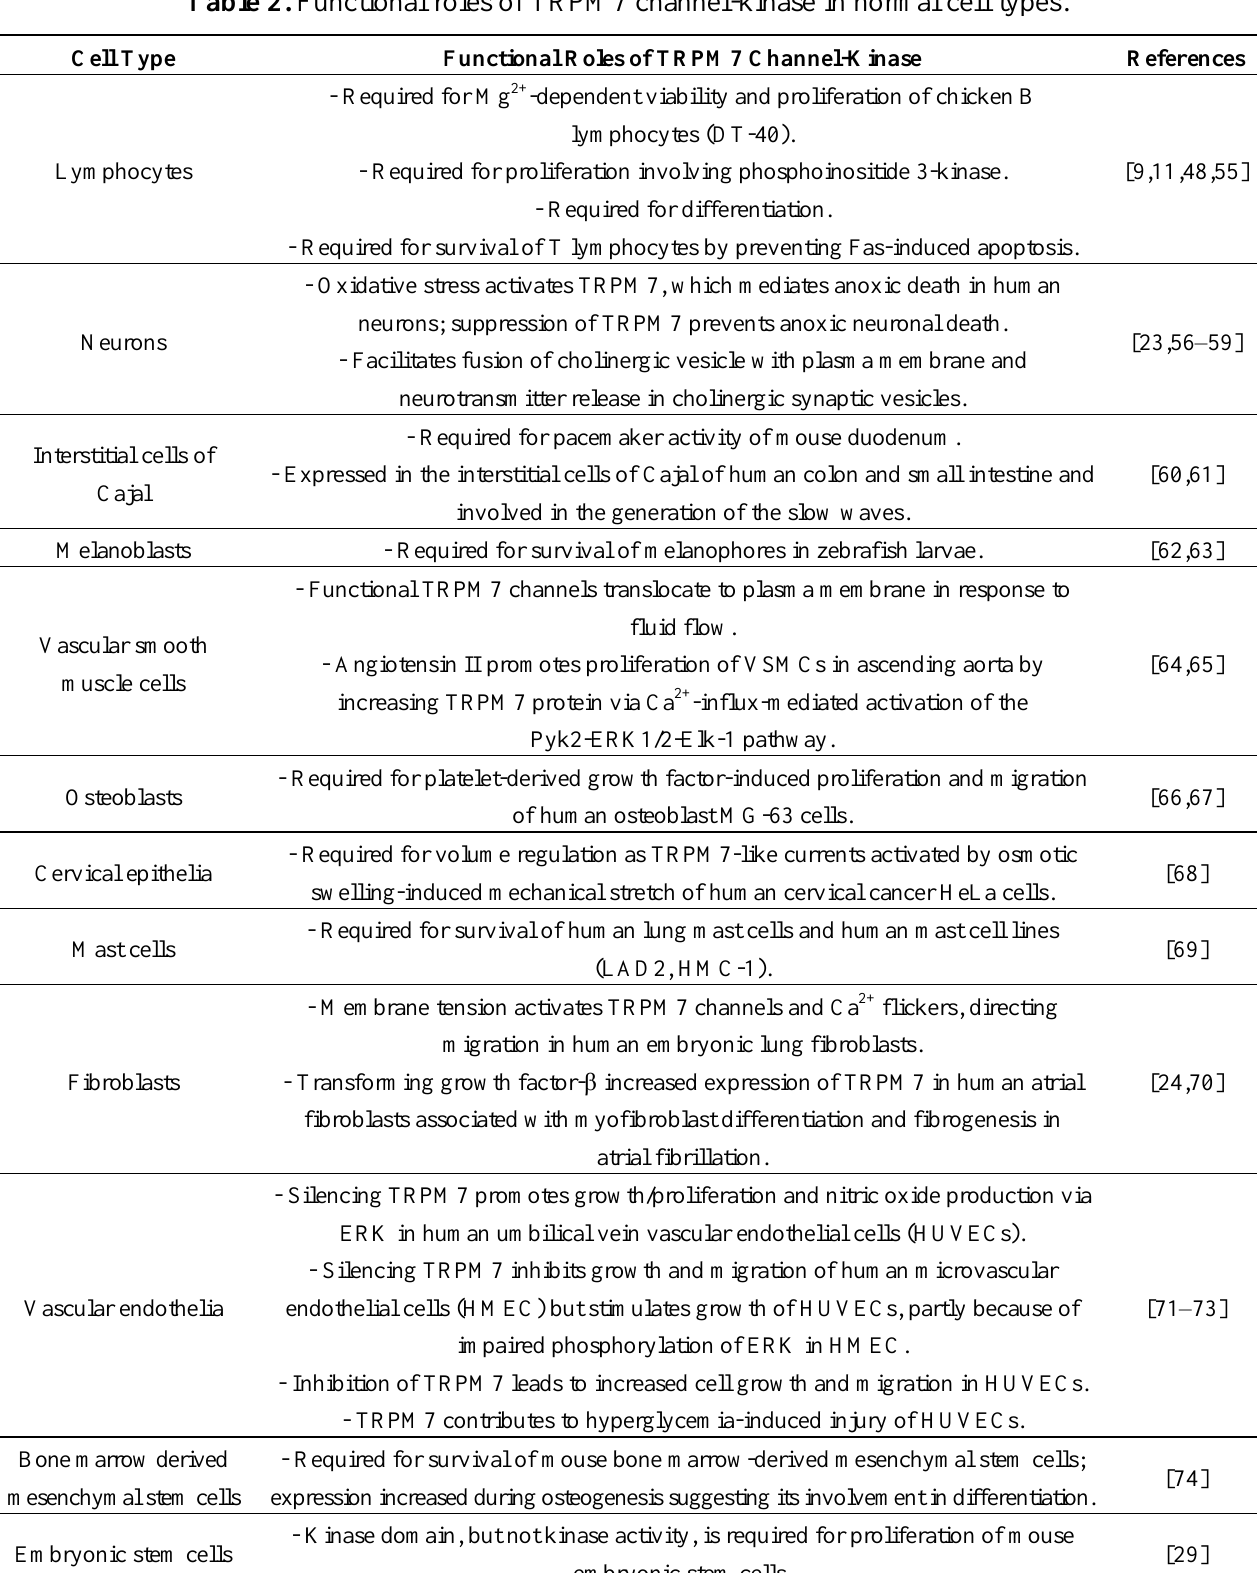
Table 2. Functional roles of TRPM7 channel-kinase in normal cell